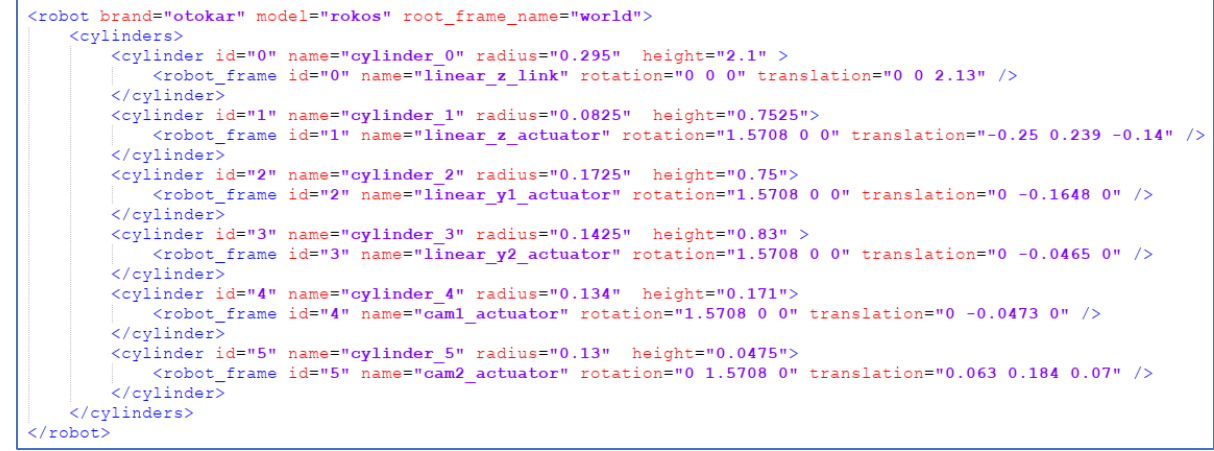
Figure 6. A sample XML for ROKOS.